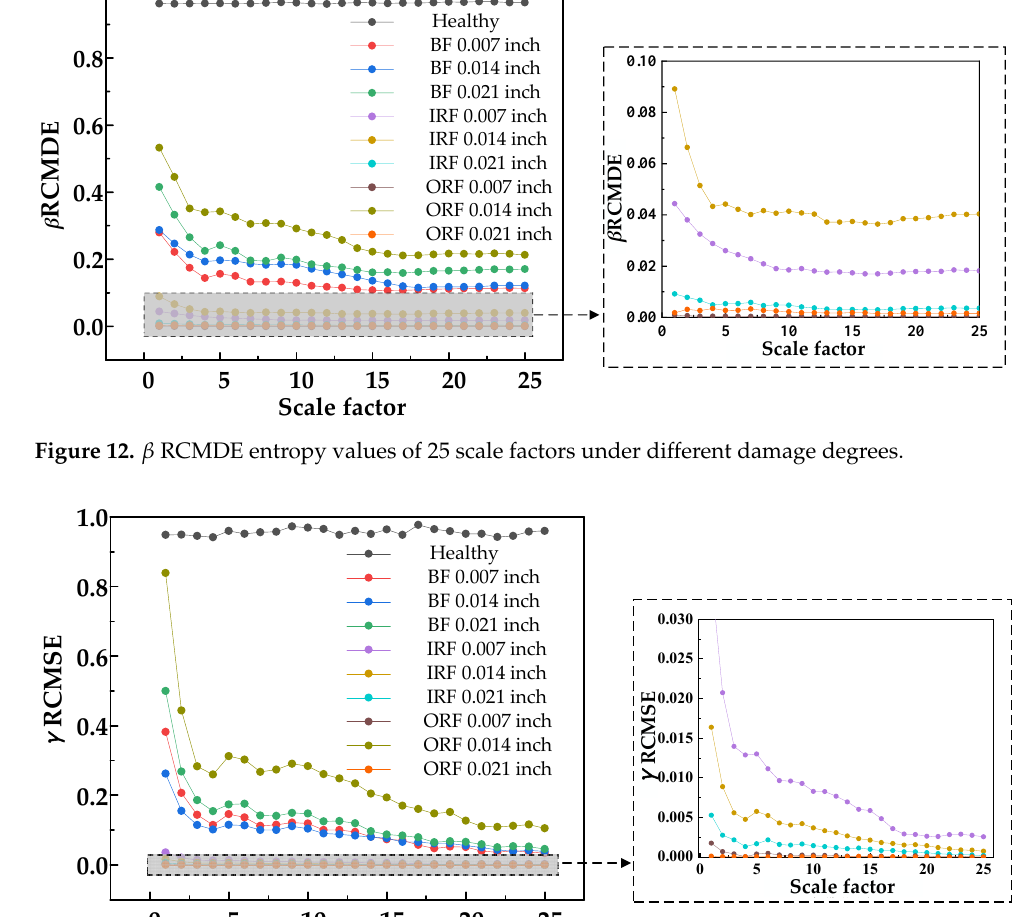
Figure 11. β RCMFE entropy values of 25 scale factors under different damage degrees.